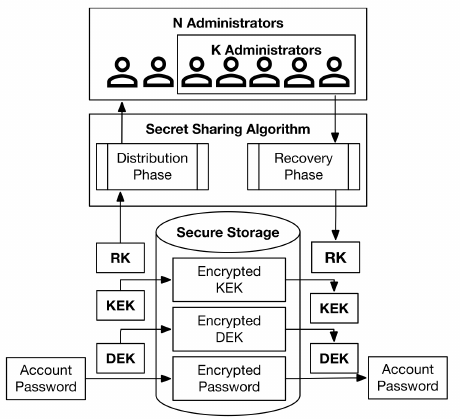
Figure 5. Hierarchical encryption of account passwords. Secret Sharing Algorithm divides RK into N key blocks for N